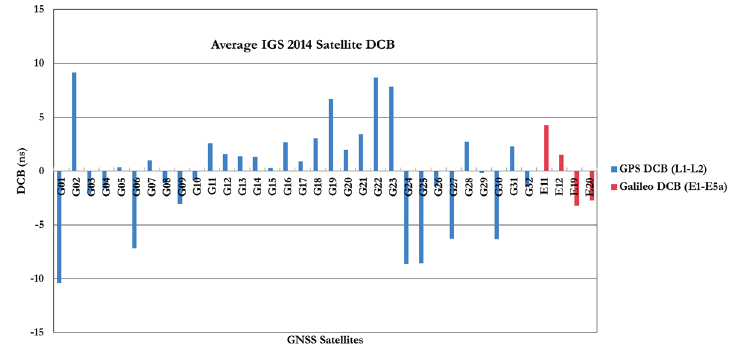
Figure 2. Average IGS 2014 satellite DCB for both GPS/Galileo